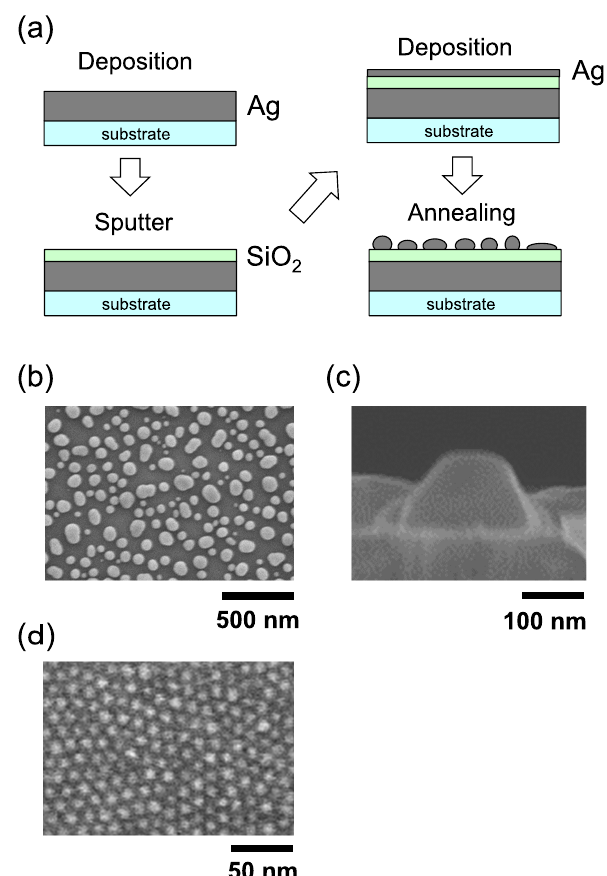
Figure 1: (a) Fabrication processes of the Ag nanohemisphere on mirror (NHoM) structure. Top view (b) and side view (c) of the scanning electron microscopy (SEM) images for the Ag nanohemispherefabricatedontheGaNsubstrate.(d)Topviewofthe SEM image of the two-dimensional (2D) nanosheet structures of the Ag nanoparticles on silicon substrate reported in [33,